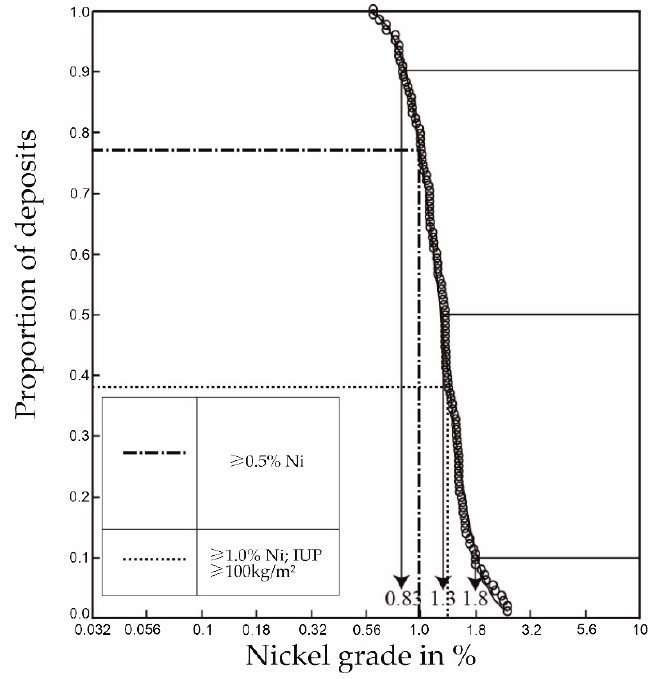
Figure 15. Summary of Ni concentration data for 117 global laterite Ni deposits with plotted Ni concentration results for Block B of the Central Halmahera deposit at several selected cut-off criteria. On the basis of [4] modified. Intercepts for the 90th, 50th, and 10th percentiles of the observed distribution are provided.